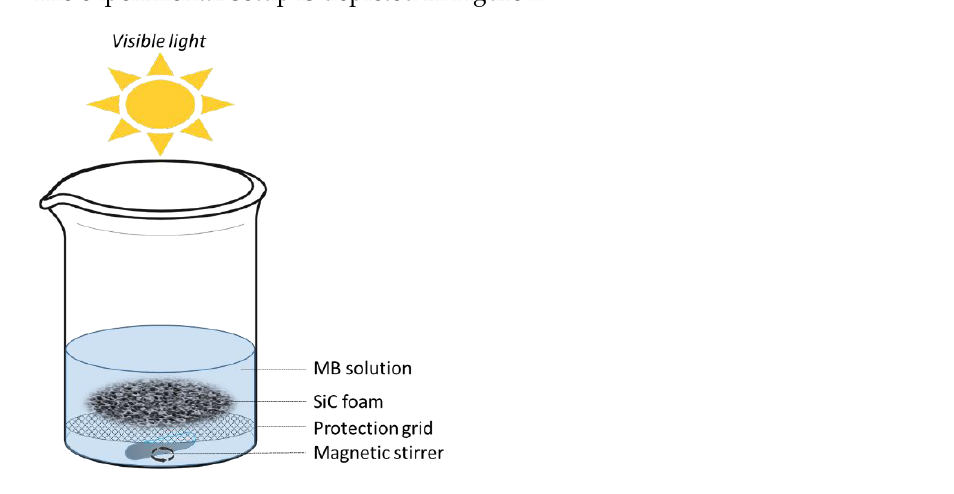
Figure 1. Setup used for the photocatalytic degradation of MB under visible light with SiC